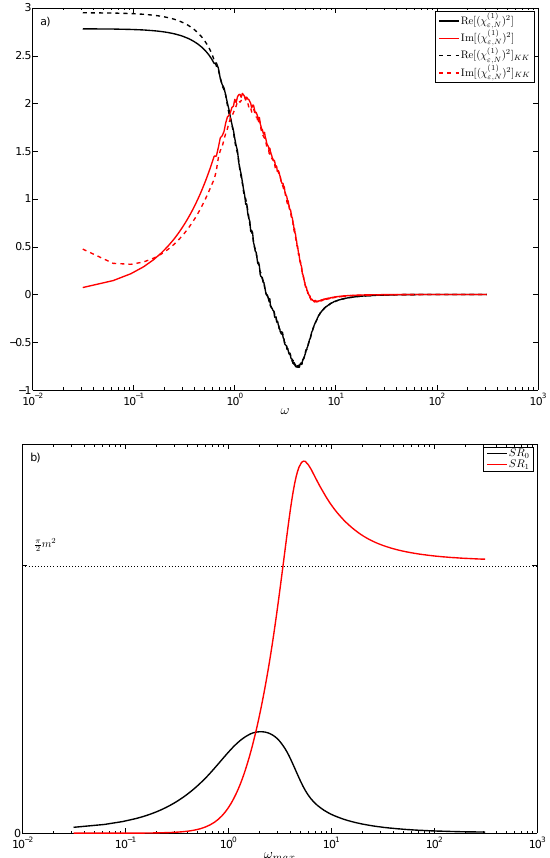
Fig. 9. Properties of the square of the linear susceptibility χ ( 1 ) The real and imaginary parts of [ χ ( 1 ) are depicted in the panel (a) , the vanishing sum rule for the real part and the non-vanishing sum rule for the imaginary part are depicted in panel (b)